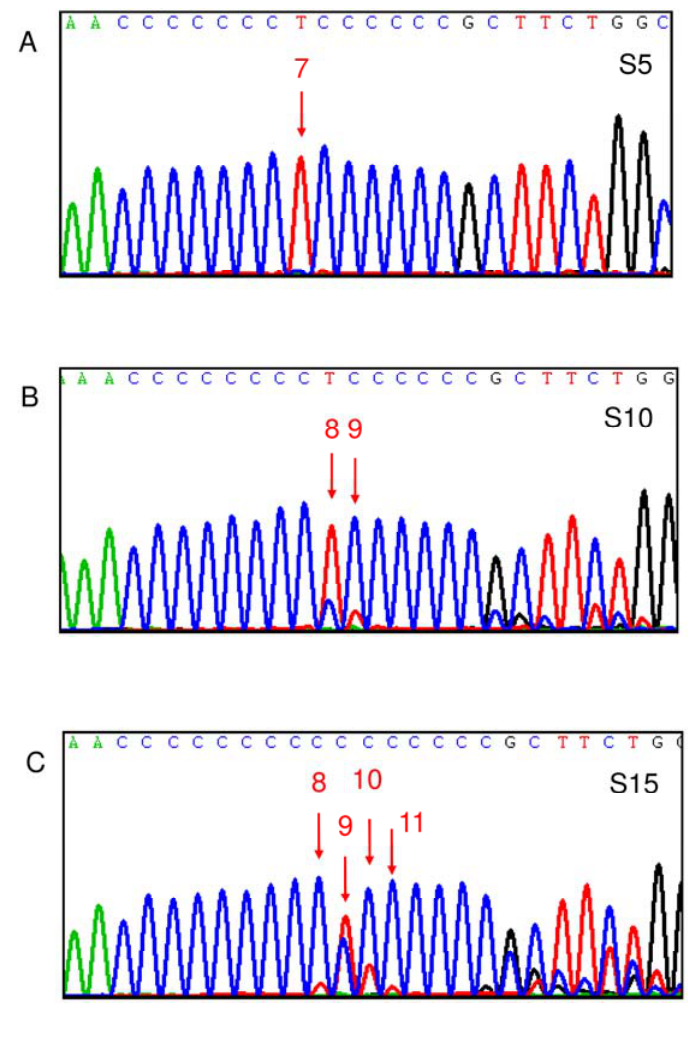
in the controls ( n = 26) were significantly higher than those of SLE patients ( n = 44) (2.845 ± 2.000 vs. 1.625 ± 1.029, p = 0.001, ND1; 1.538 ± 1.108 vs. 0.928 ± 0.526, p = 0.003, ATPase 6; Student t test). Figure 1. Representative cases to demonstrate the D310 sequence variations. T (thymine) is shown in red, A (adenine) in green, C (cytosine) in blue and G (guanine) in black during sequencing. The Arabic number above the red arrow denotes the number of C before the indicated T peak. ( A ) In patient S5, leukocyte mtDNA harbored 1 kind of D310 variant, C TC . As a result, S5 was classified as D310 homoplasmy with C TC being the dominant 7 6 7 6 TC variant; ( B ) In patient S10, leukocyte mtDNA harbored 2 kinds of D310 variants, C 8 6 and C TC in order, with C TC being the dominant one. As a result, S10 was classified as 9 6 8 6 D310 heteroplasmy with C TC as the dominant variant; ( C ) In patient S15, leukocyte 8 6 TC , C TC , C TC and C TC in order, mtDNA harbored 4 kinds of D310 variants, C 9 6 10 6 8 6 11 6 with C TC being the dominant one. As a result, S15 was classified as D310 heteroplasmy 9 6 with C TC as the dominant variant. Clinically, patient S15 developed lupus 9 6